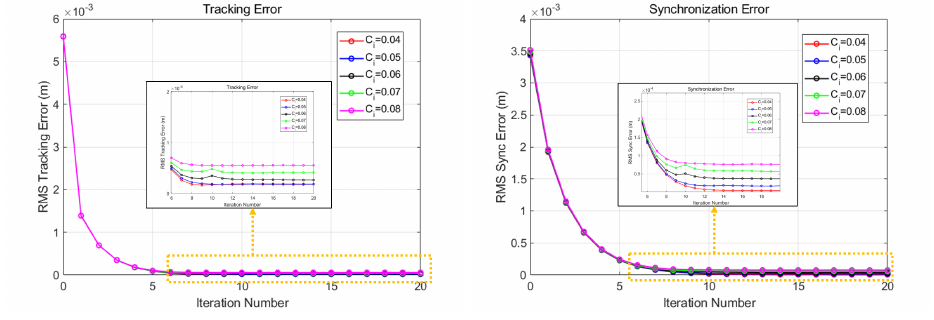
Figure 4. Simulation result for